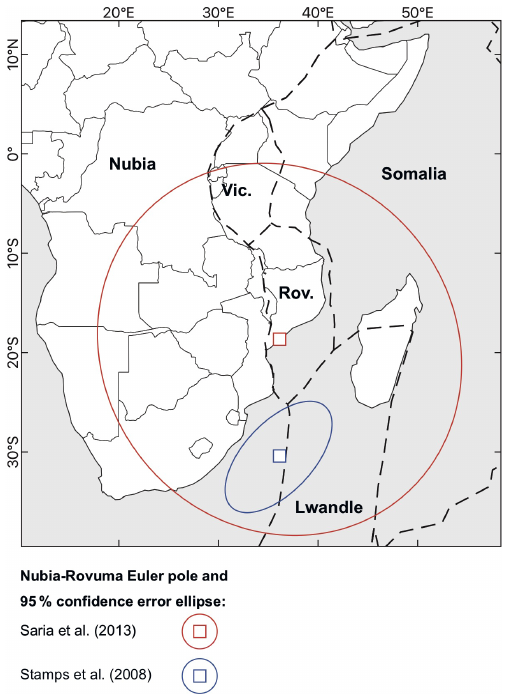
Figure A1. Plate boundaries in East Africa with location and un- certainty of the Nubia–Rovuma Euler pole derived by Saria et al. (2013) and Stamps et al. (2008). “Vic.” denotes Victoria, and “Rov.” denotes Rovuma. Modified after Saria et al.